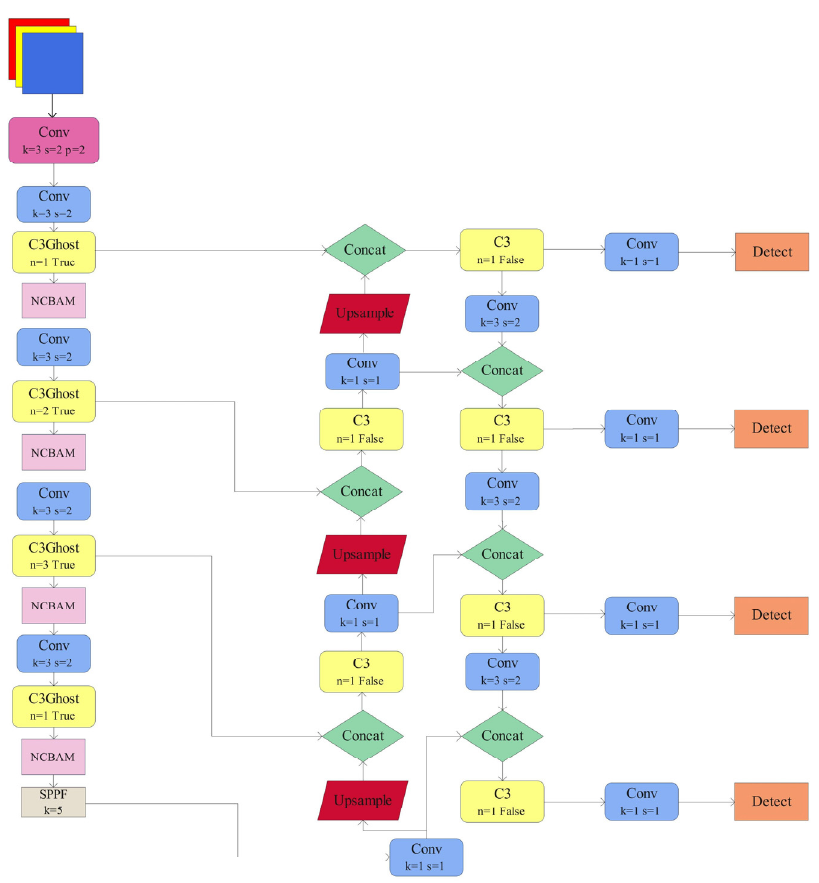
Figure 7. Figure 7. Improved YOLOv5 network structure (The arrows indicate the direction of forward propagation).